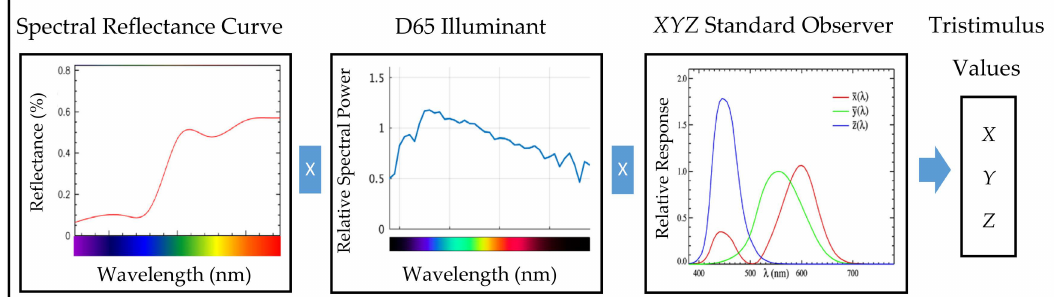
Figure 2. Tristimulus values.